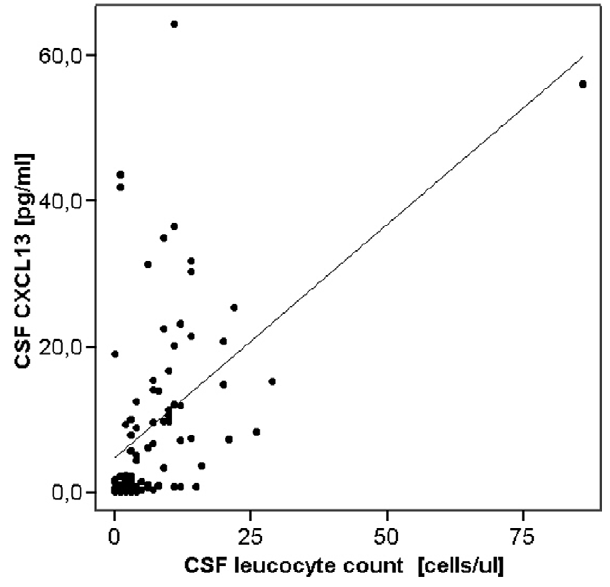
Figure 3. Relation of CXCL13 to cell count. Dot plot shows CSF CXCL13 in patients with CIS plotted against CSF leucocyte count. Straight line represents regression line; correlation was significant (p , 0.001, R=0.59).